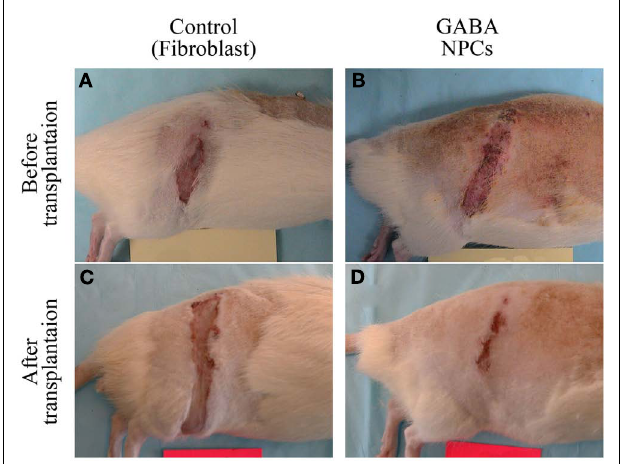
FIGURE 5 | Photomicrographs showing changes in size of overgrooming in QUIS animals transplanted with control bovine fibroblast cells [pretransplantation: (A) 3 weeks post: (C)] and predifferentiated GABA-IR NPCs [pretransplantation: (B), 3 weeks post: (D)].